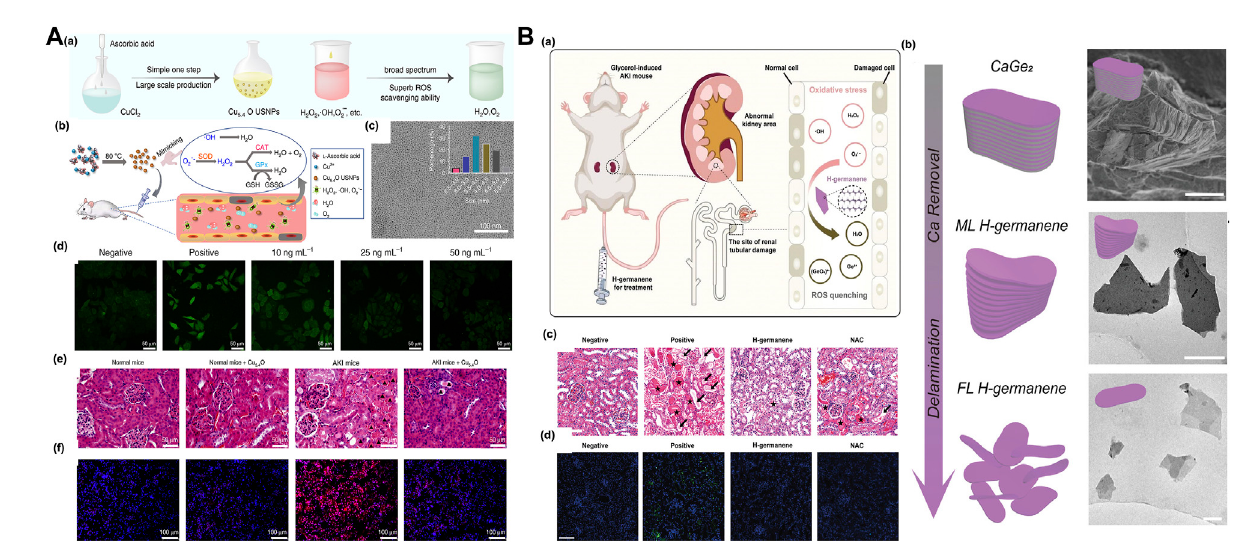
FIGURE 6 (A)(a) SchematicofsyntheticprocessofCu 5.4 OUSNPs(ultrasmallnanoparticles)withbroadROSscavengingproperty, (b) Cu 5.4 OUSNPsexhibitedSOD, CAT and GPx-mimicking activity present the potentiality for treatment of oxidative stress related injury, (c) TEM image of Cu 5.4 O USNPs, (d) Representative ROS staining of HEK293 cells with different Cu 5.4 O USNPs treatment, the therapeutic ef fi cacy of Cu 5.4 O USNPs in vivo : (e) H&E staining of kidney tissues (f) Dihydroethidiumstainingofkidneytissuesforeachgroup.Adaptedwithpermissionfrom(Nat.Commun.2020,11,2788.)(LiuS.etal.,2020b); (B)(a) The schematic illustration of H-germanene as an ROS-quenching agent accumulated at the damaged renal tubular for AKI treatment, (b) characterization of precursor CaGe 2 and H-germanene nanosheets: synthetic process of the H-germanene (left) and SEM image of the precursor CaGe 2 , TEM images of ML H-germaneneandFLH-germanene(right), (c) H&Estainingofthekidneytissues, (d) TUNELstainingofthekidneytissues.Adaptedwithpermissionfrom(Adv. Sci. 2022, 9, 2202933.) (Chen et al.,